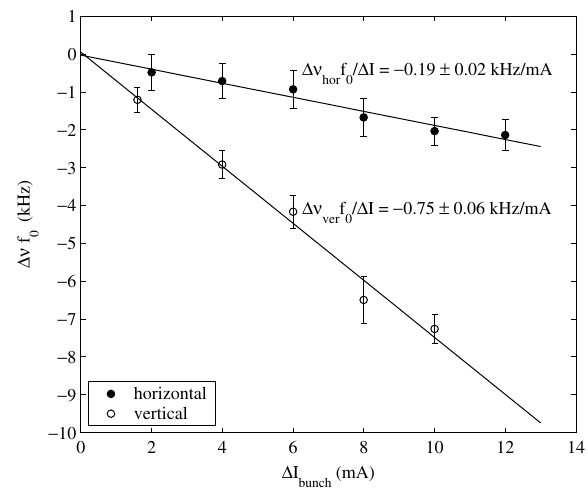
FIG. 7. Horizontal and vertical coherent tune